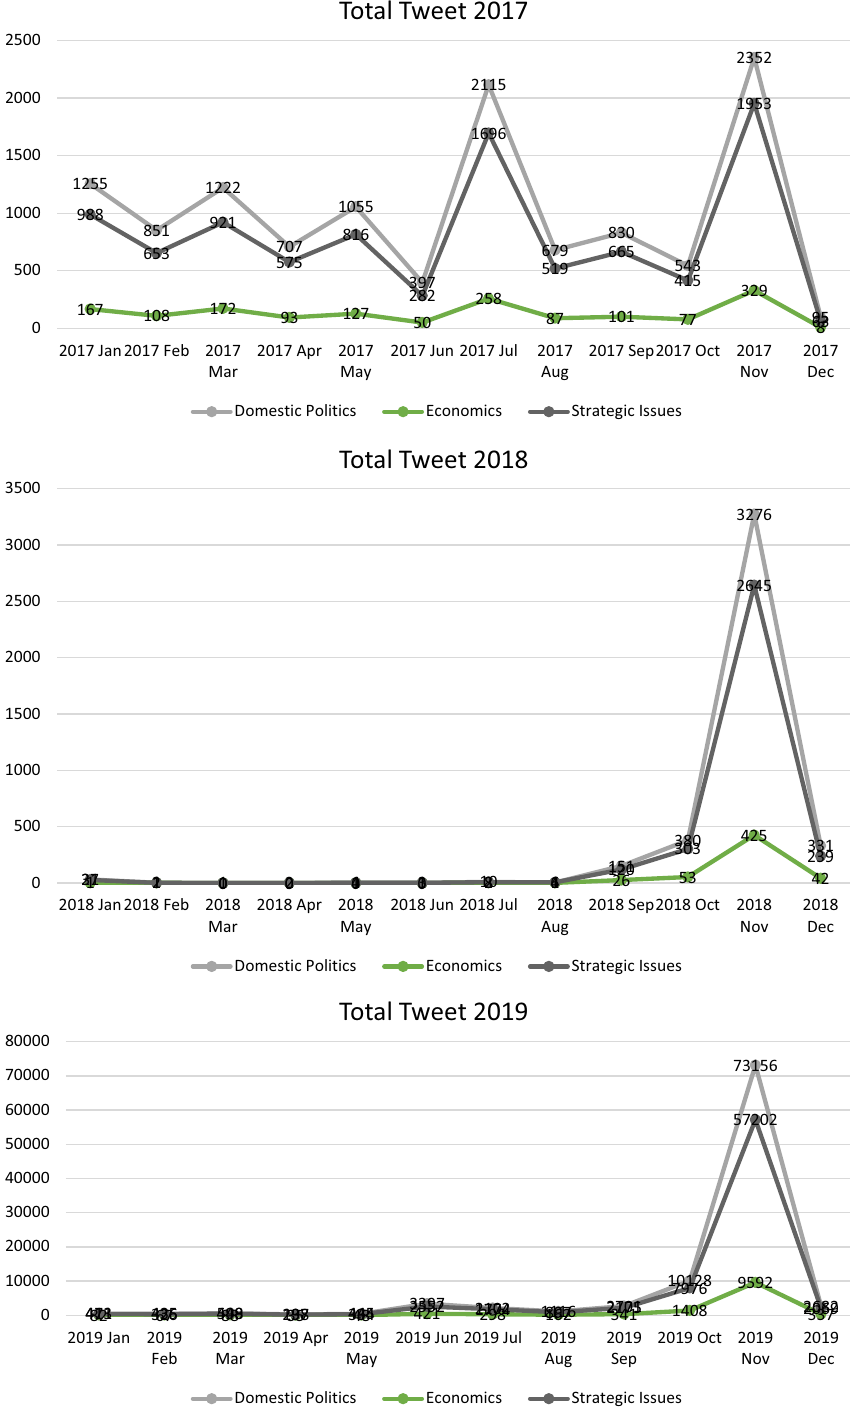
Fig. 7 Distribution of RCEP tweets per month